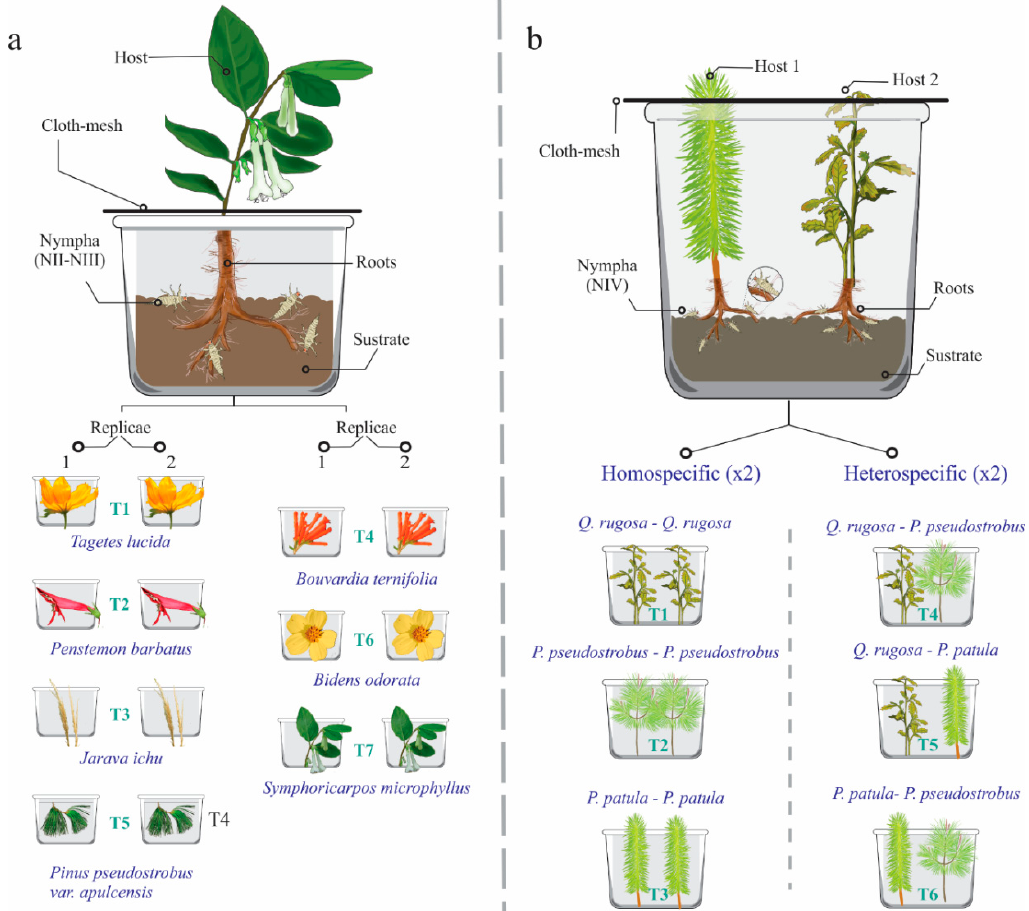
Figure 2. Diagrams of the two experiments to evaluate host preferences of Ocoaxo assimilis ; in both experiments, substrate from the same sampling site, host plants, and insects were put inside of plastic boxes. a ) Experiment 1: seven treatments were considered (T1–T7) corresponding to seven host species, respectively, each of them was carried out in duplicate (two plants per species); in each box a plant and four insects from nymphal stage one (NI) to three (NIII) were included, for a total of 14 host plants and 56 insects. b ) Experiment 2: six treatments were considered (T1–T6) corresponding to six homo and hetero specific combinations of three hosts of tree species, each treatment was performed in duplicate; in each box, two plants and eight insects from nymphal stage four (N4) were included, in total, 14 host plants and 96 insects were studied.